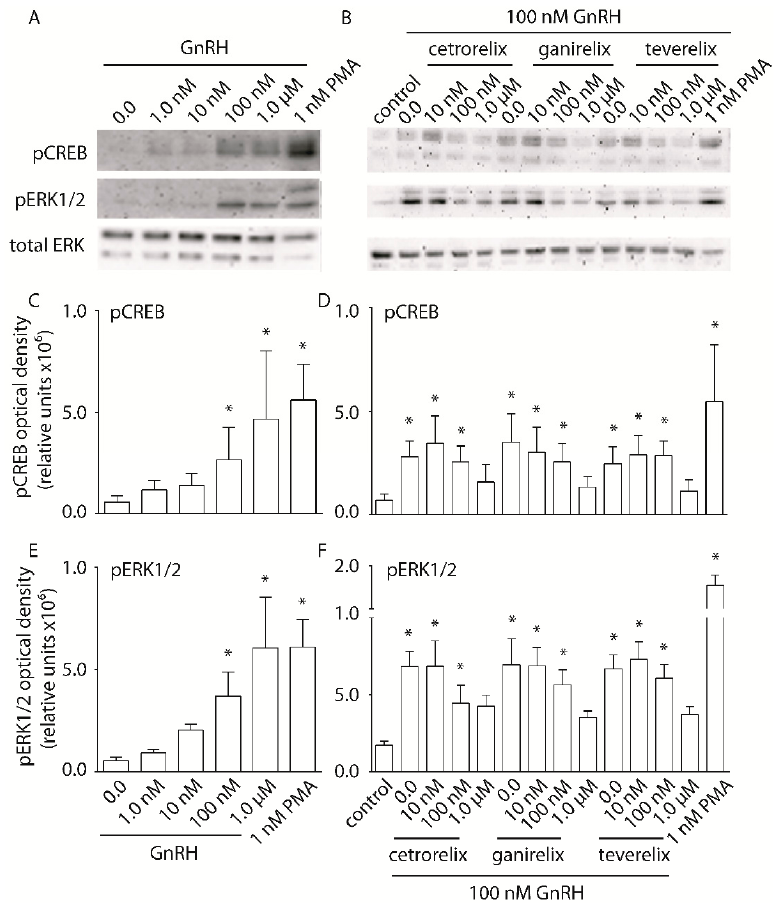
Figure 4. GnRH-induced pERK1 / 2 and pCREB activation, and inhibition exerted by GnRH antagonists, in HEK293 / GnRHR cells. ( A ) Cells were treated 15 min with increasing GnRH concentrations (pM– µ M range) and the phosphorylation of ERK1 / 2 and CREB was evaluated by Western blotting. Untreated samples are used as negative controls, while samples treated by 1 nM PMA served as positive control. Total ERK was the loading control. Images are representative of three independent experiments. ( B ) Cetrorelix, Ganirelix and Teverelix dose-inhibition of 100 nM GnRH-induced pERK1 / 2 and pCREB activation. Images are representative of three independent experiments. ( C – F ) Semi-quantitative evaluations of pCREB and pERK1 / 2 Western blotting signals displayed in panels A and B, by an image analysis software. Bars indicate means ± SEM (* = significantly di ff erent versus control; Kruskal-Wallis test; p < 0.05; n =